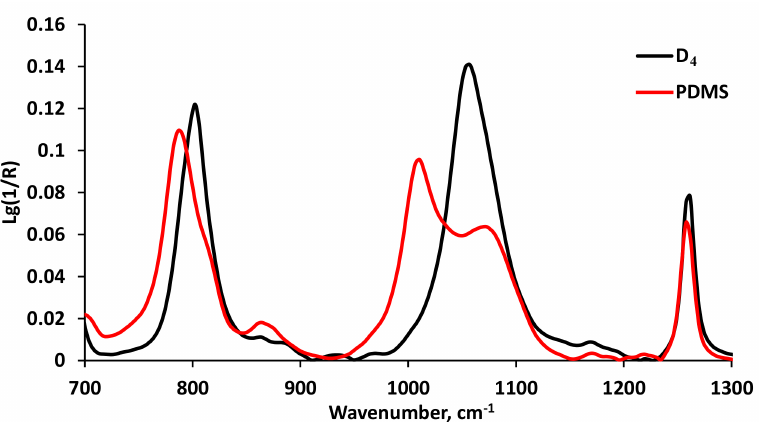
Figure 2. FTIR spectra of D 4 and polydimethylsiloxane